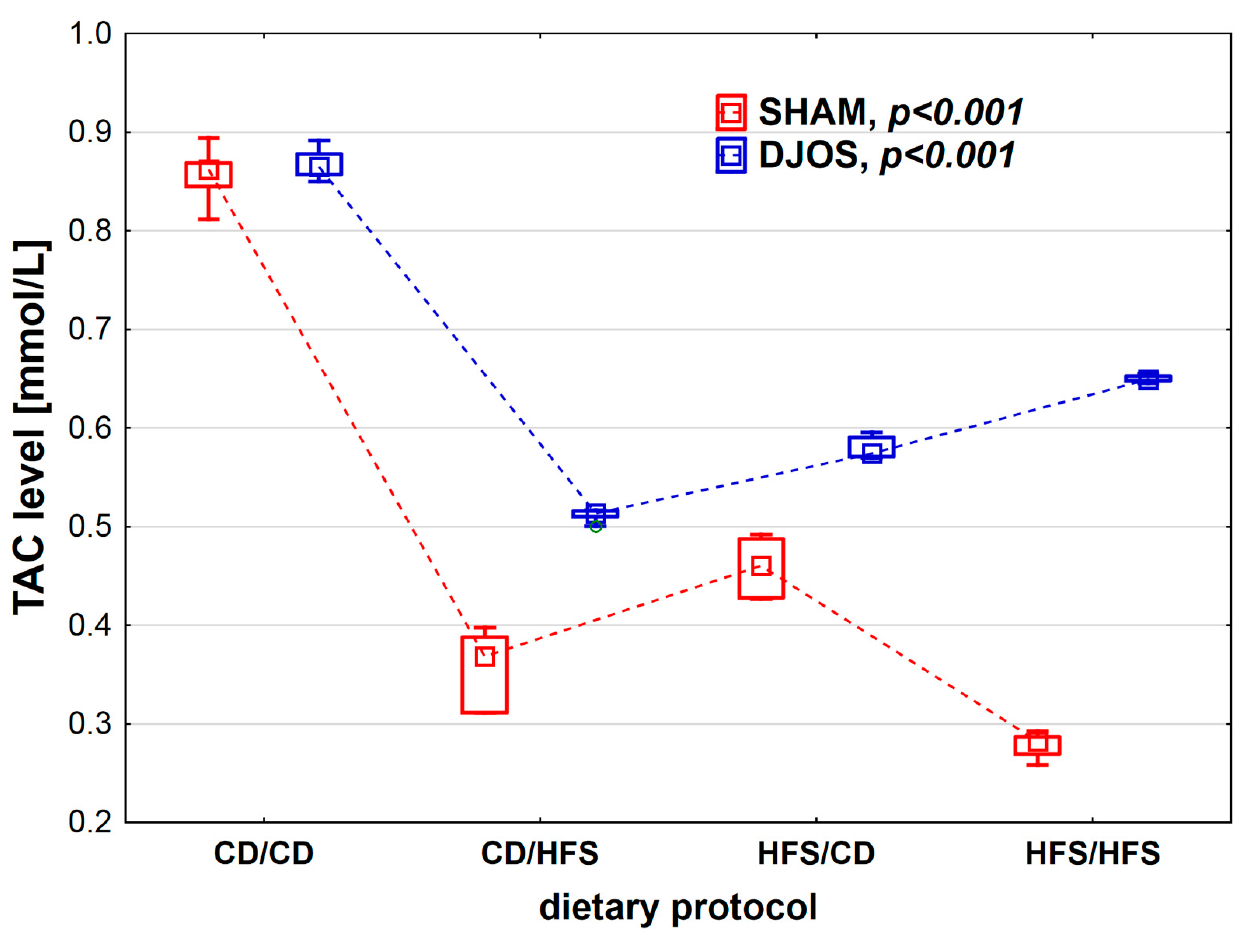
Figure 4. Total antioxidant capacity (TAC) level (mmol/L) in the plasma of Sprague-Dawley rats subjected to duodenojejunal omega switch (DJOS) and control (SHAM) surgery and different dietary protocols at 8 weeks after the surgery. Legend: CD—control diet, HFS—high-fat/high-sugar diet. The inner boxes represent the medians, the outer boxes represent interquartile ranges, and whiskers represent min–max range. For the reader’s convenience, the medians are connected with dashed lines.